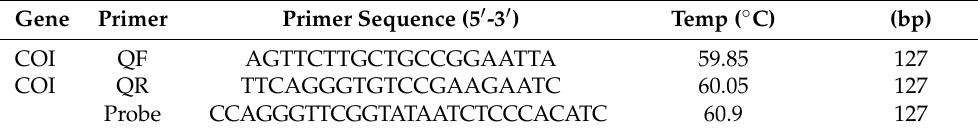
Table 3. Primer pairs (QF-Forward, QR-Reverse) and probe used for the qPCR analysis of eDNA. Gene